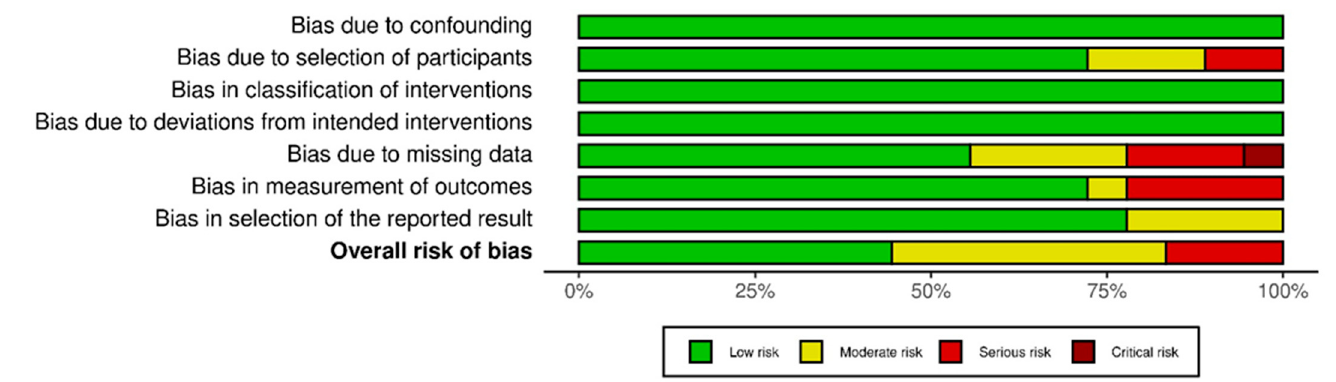
Figure 2. Risk of bias of the studies included individually [18,25–41].